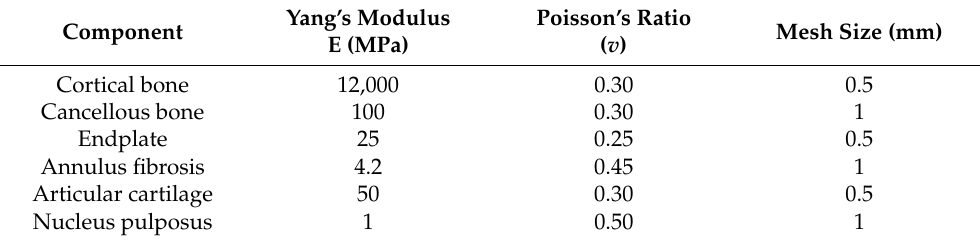
Table 1. Material properties and mesh sizes of solid parts.